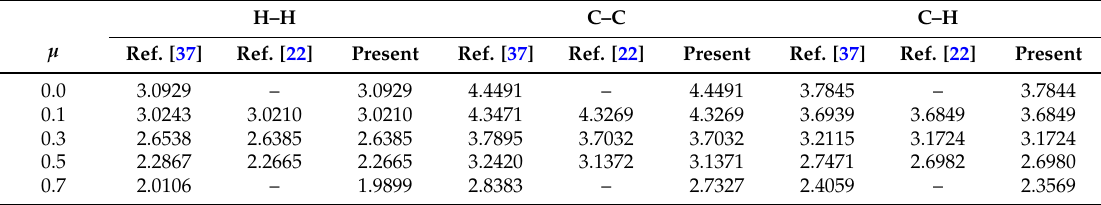
Table 2. Comparison of dimensionless linear frequency ( ω l 2 different nonlocal parameter µ and various endpoint conditions.